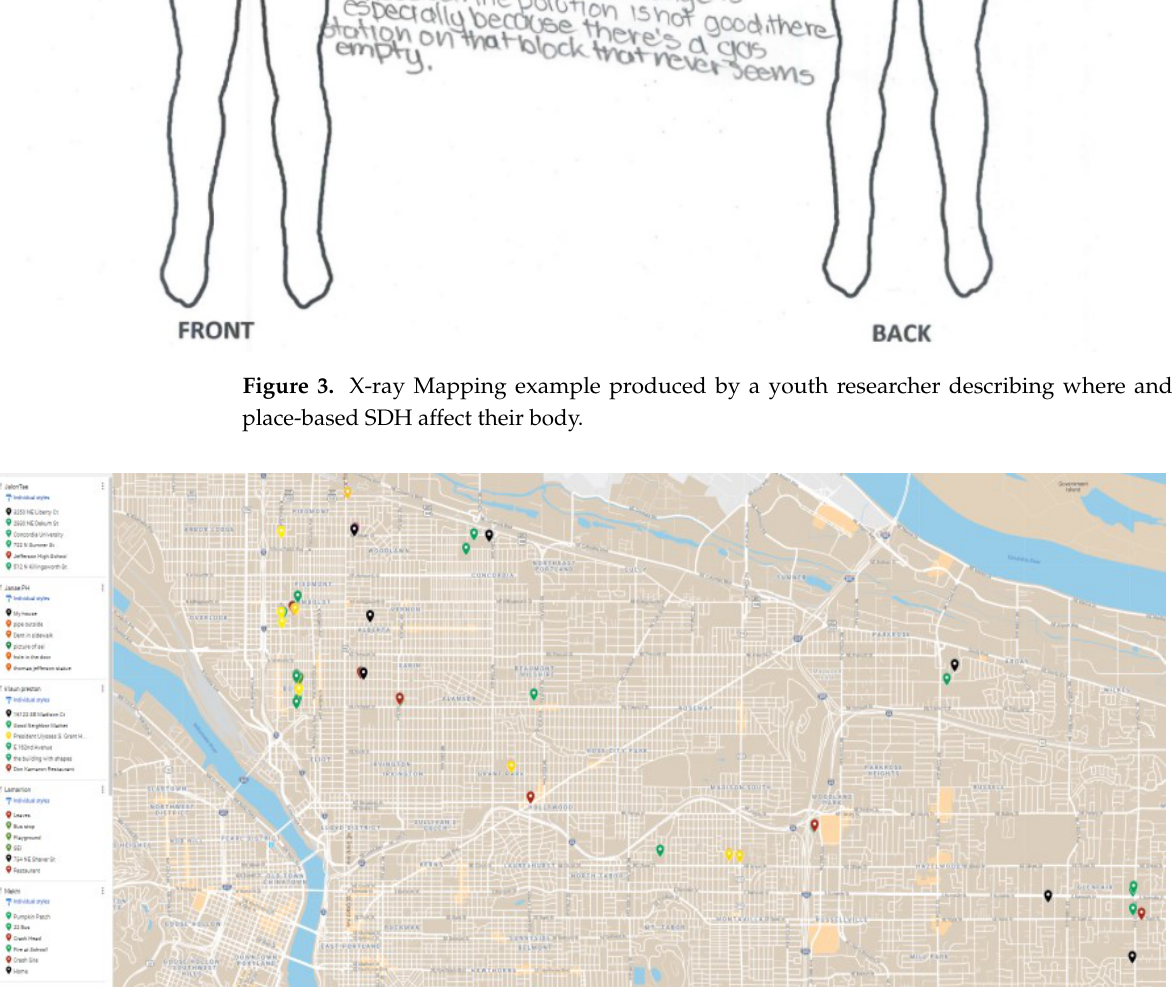
Figure 4. A summary Participatory GIS map showing the locations of some of the daily place-based SDH experiences youth identified. Green = “positive/healthy/good”, Red = “negative/unhealthy/bad”, and Yellow = both “positive” and “bad”.